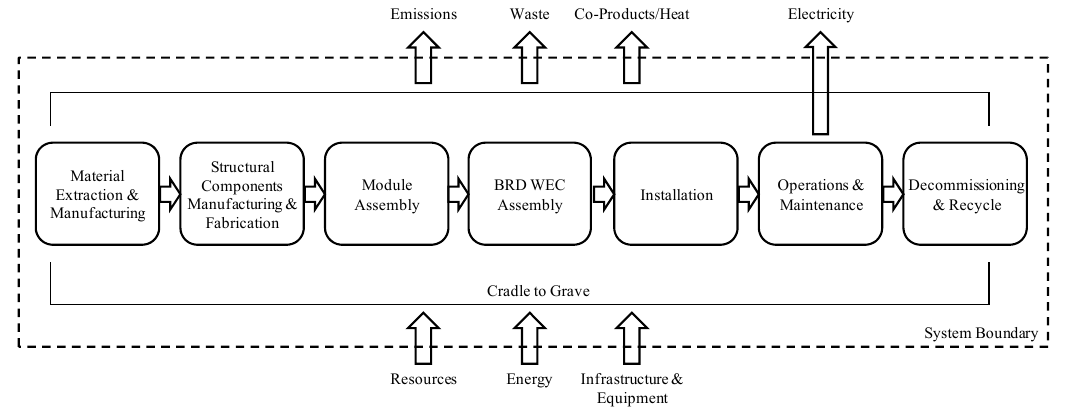
Figure 2. Life cycle of BRD WEC and system boundary.